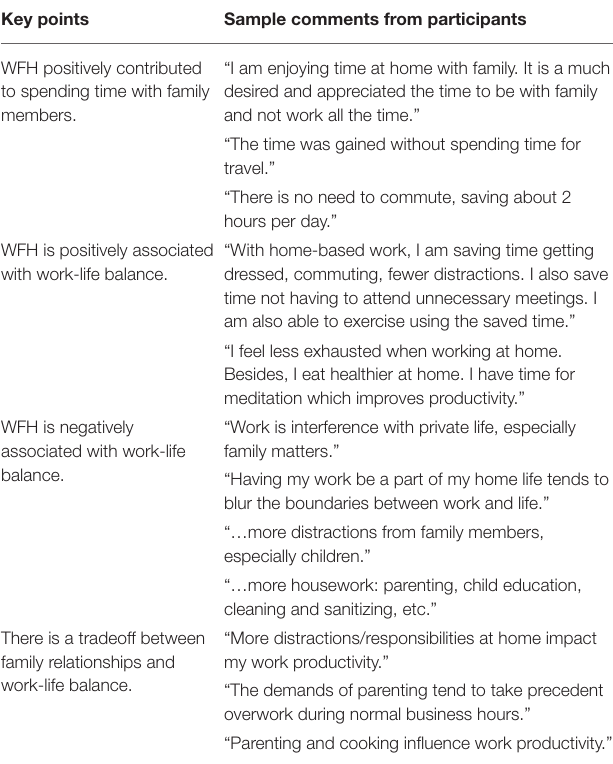
TABLE 5 | Summary of sample comments from